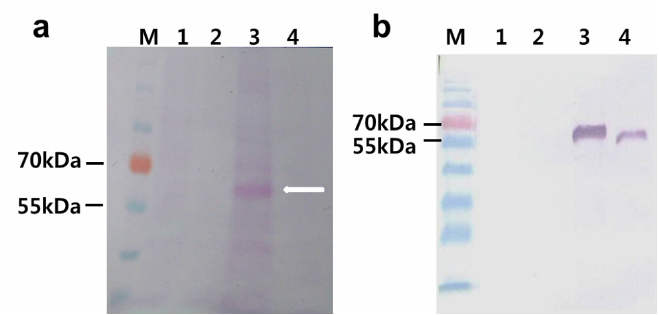
Figure 5. Detection of the glycosylated rPhy-P from the total protein extracts of agro-infiltrated leaf tissues with Agrobacterium containing pPZP212-phy at 5 dpi. ( a ) Schiff’s reagent-stained 10% SDS-PAGE gel. Lane M, molecular weight markers; Lane 1, the purified rPhy-E; Lane 2, total protein extracted from mock-infiltrated leaf; Lane 3, untreated total protein extracted from agro-infiltrated leaf tissues at 5 dpi with peptide- N -glycosidase F; Lane 4, treated total protein extracted from agro-infiltrated leaf tissues at 5 dpi with peptide- N -glycosidase F; ( b ) Western blot analysis of